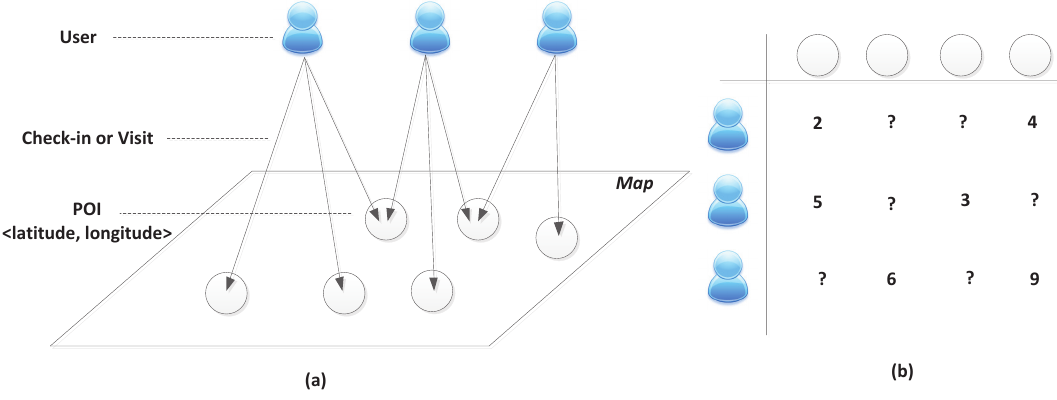
Figure 1. Example of point-of-interest (POI) recommendation in location-based social networks (LBSNs). ( a ) Overview of location-based social network; ( b ) user-POI check-in frequency